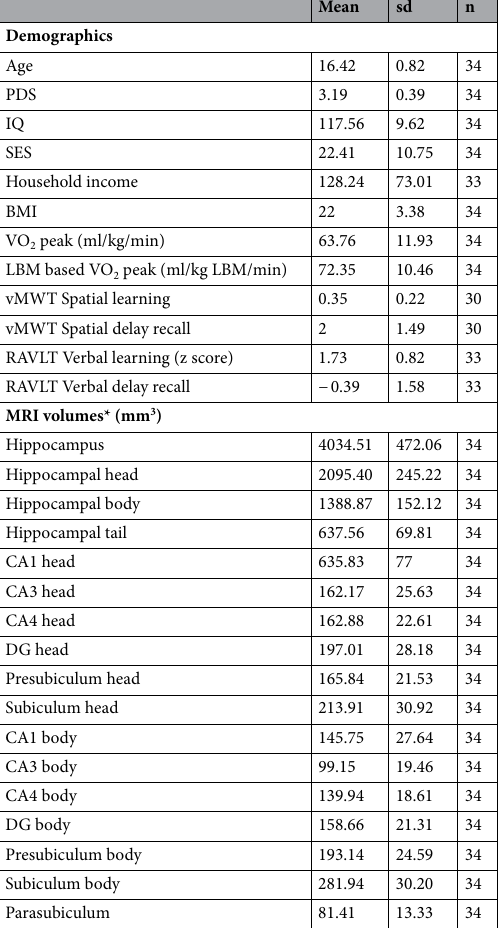
Table 1. Participant demographics. sd standard deviation, IQ Wechsler Abbreviated Scale of Intelligence, SES Hollingshead Index of Social position, vMWT Virtual Morris Water Maze Task, RAVLT Rey Auditory Verbal Learning Test, CA cornu ammus, DG dentate gyrus. *Left and right region of each subfield are